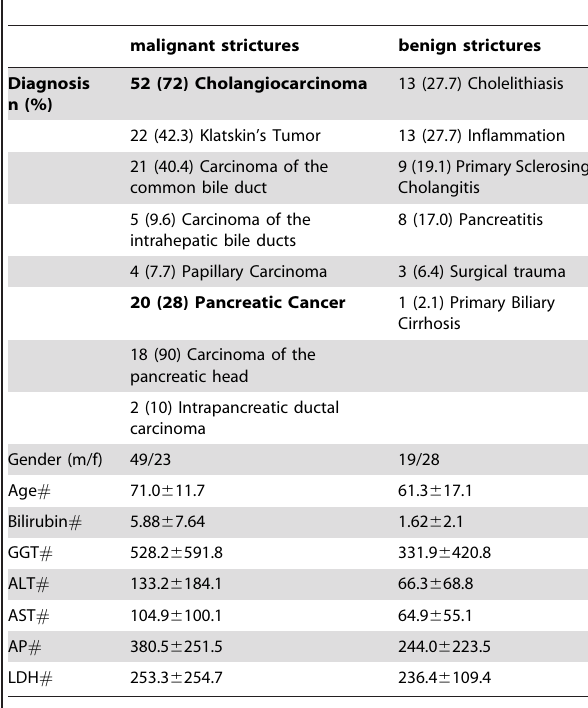
Table 1. Clinical characteristics of